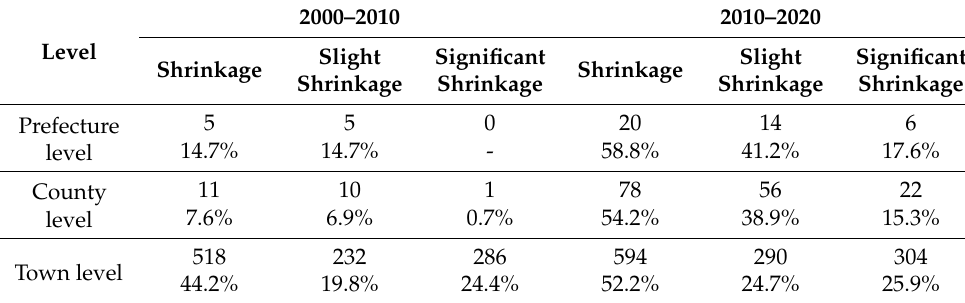
Table 2. Number of shrinking cities and towns in Northeast